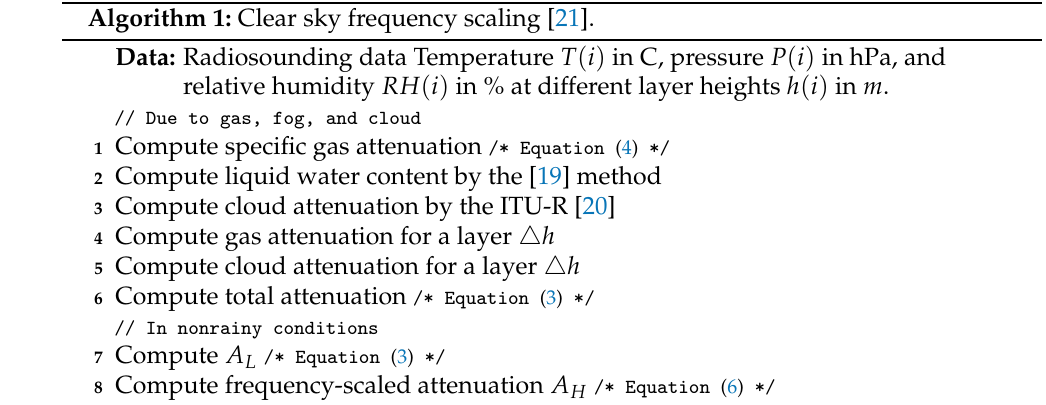
Algorithm 1: Clear sky frequency scaling [21].